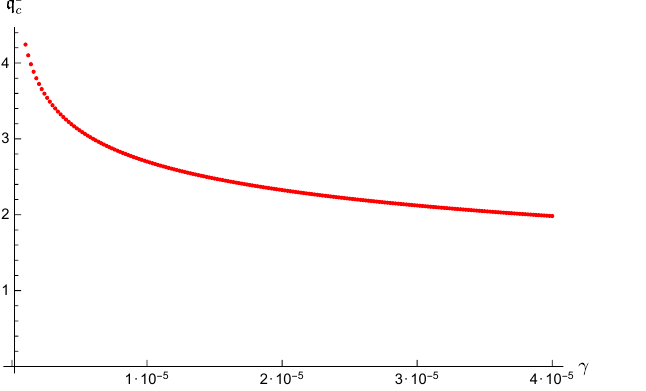
Figure 3 . The value of the (real) spatial momentum squared, limiting the hydrodynamic regime, as a function of the (inverse) coupling γ in the shear channel of the N = 4 SYM [16]. Hydrodynamics has a wider range of applicability in q 2 at smaller γ (larger ’t Hooft